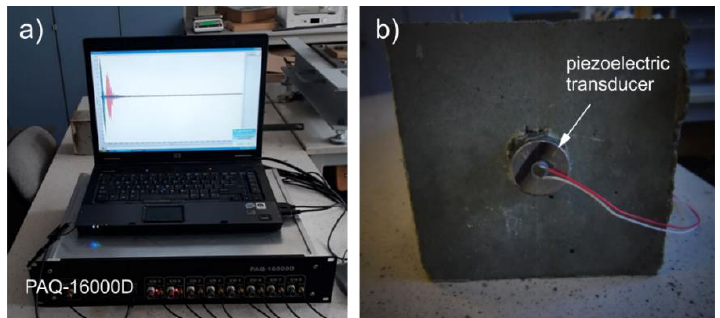
Figure 9. The photograph of ( a ) experimental equipment and ( b ) piezoelectric transducer attached to the end of the beam.